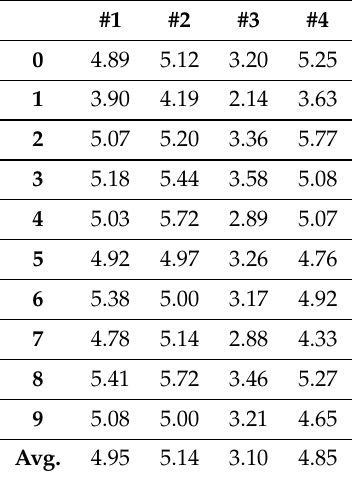
Table 11. The sums of occurrence intensities (values in the encoding) for each visual feature AF4 . It must be emphasized that the results in this table are relative, so they can only be compared to the numbers from the same